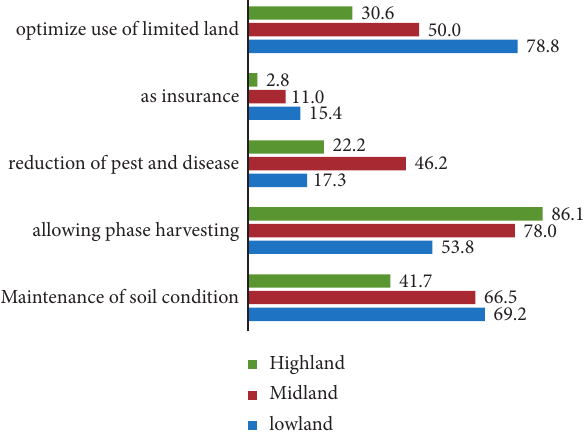
Figure 5: Farmers reason for conserving plant diversity in the same